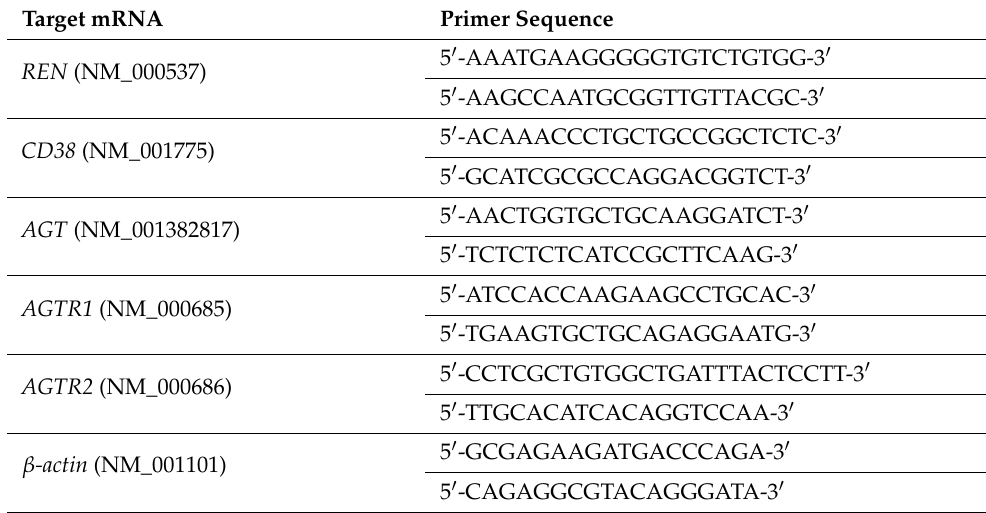
Table 1. PCR primers (human) for the real-time RT-PCR. Target